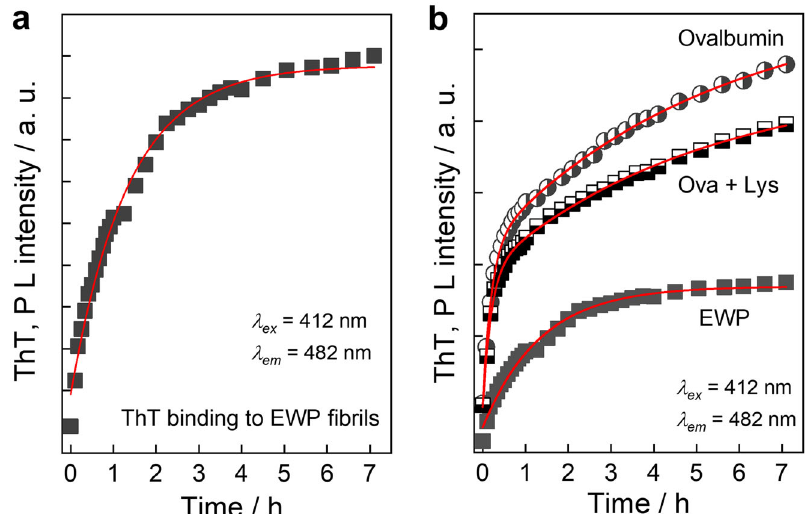
Fig. 3 Kinetics of fi brillation. a Time dependence of the photoluminescence (P L) intensity of the Thio fl avin T dye upon binding to the cross-beta structure formed due to EWP fi brils formation and b comparative ThT, P L intensity vs. time plots for ThT binding to ovalbumin, ovalbumin + lysozyme, and EWP fi